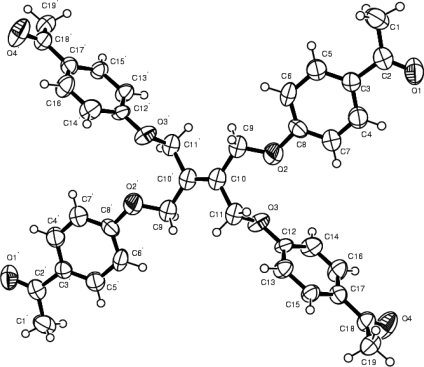
ORTEP drawing of the crystal structure of C38H36O8